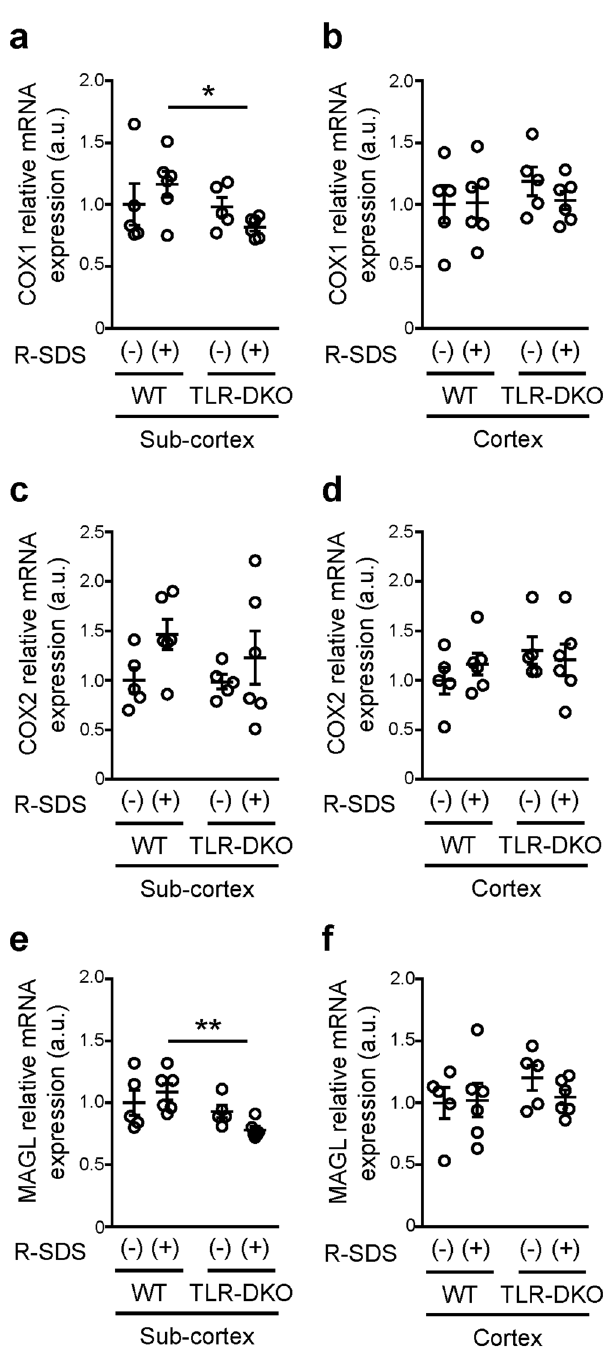
Figure 2. TLR2/4 are involved in the expression of COX1 and MAGL after repeated social defeat stress in subcortical tissues. The relative mRNA expression levels of COX1 ( a , b ), COX2 ( c,d ) and MAGL ( e,f ) in subcortical ( a,c,e ) and cortical ( b,d,f ) tissues of wild-type (WT) and TLR2/4 double knockout (TLR-DKO) mice with or without repeated SDS (R-SDS). * P < 0.05, ** P < 0.01 for Bonferroni’s multiple comparisons test. Data are shown as means ±